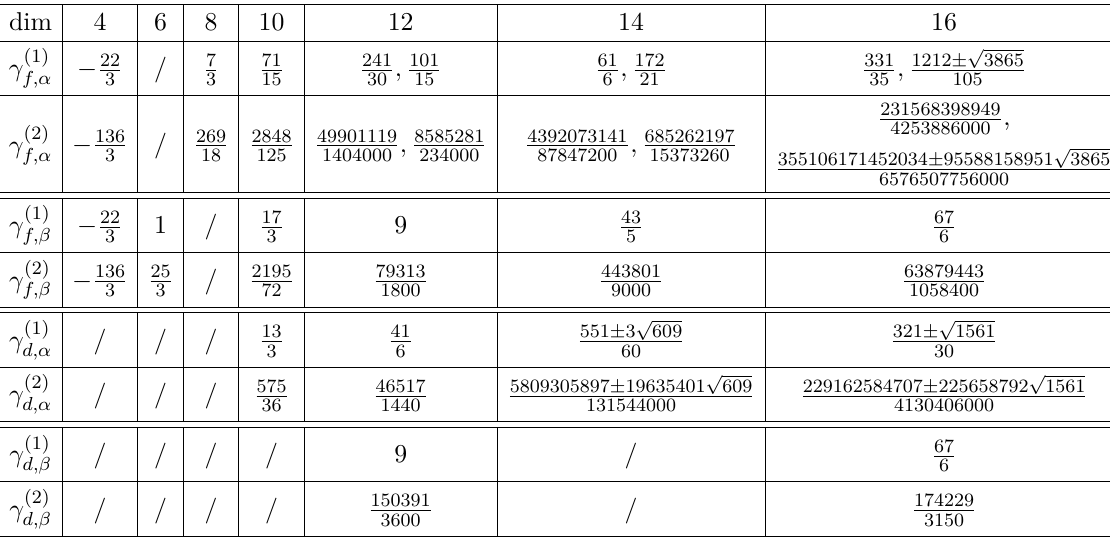
Table 8 . Summary of anomalous dimensions for length-2 and length-3 operators. The lower dimension operators will appear as descendants in the high dimension